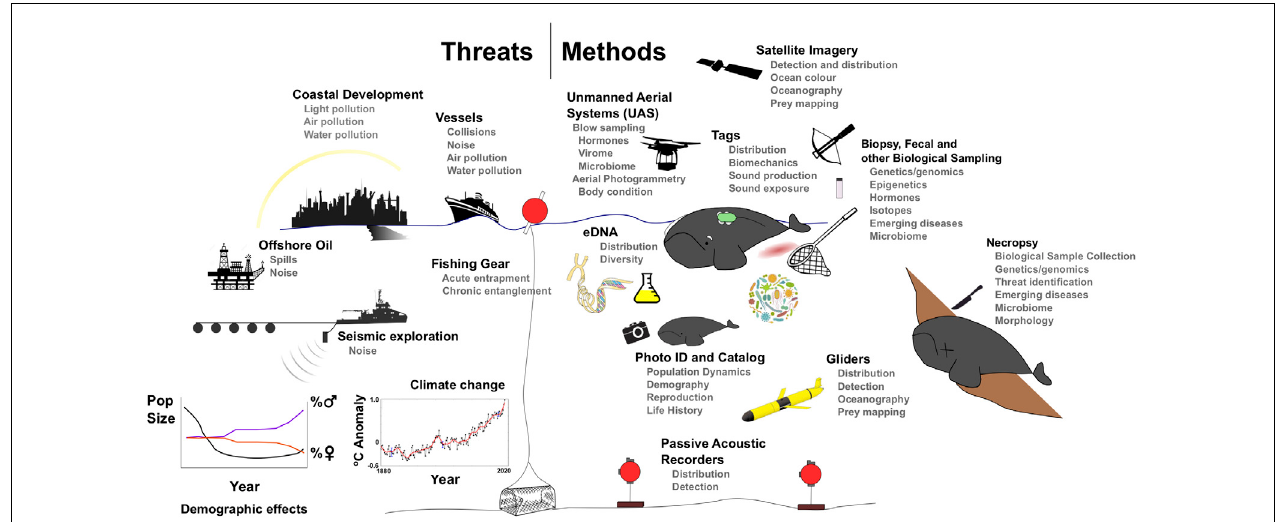
FIGURE 3 | Current and future threats to (left) and methods to study (right) global right whale